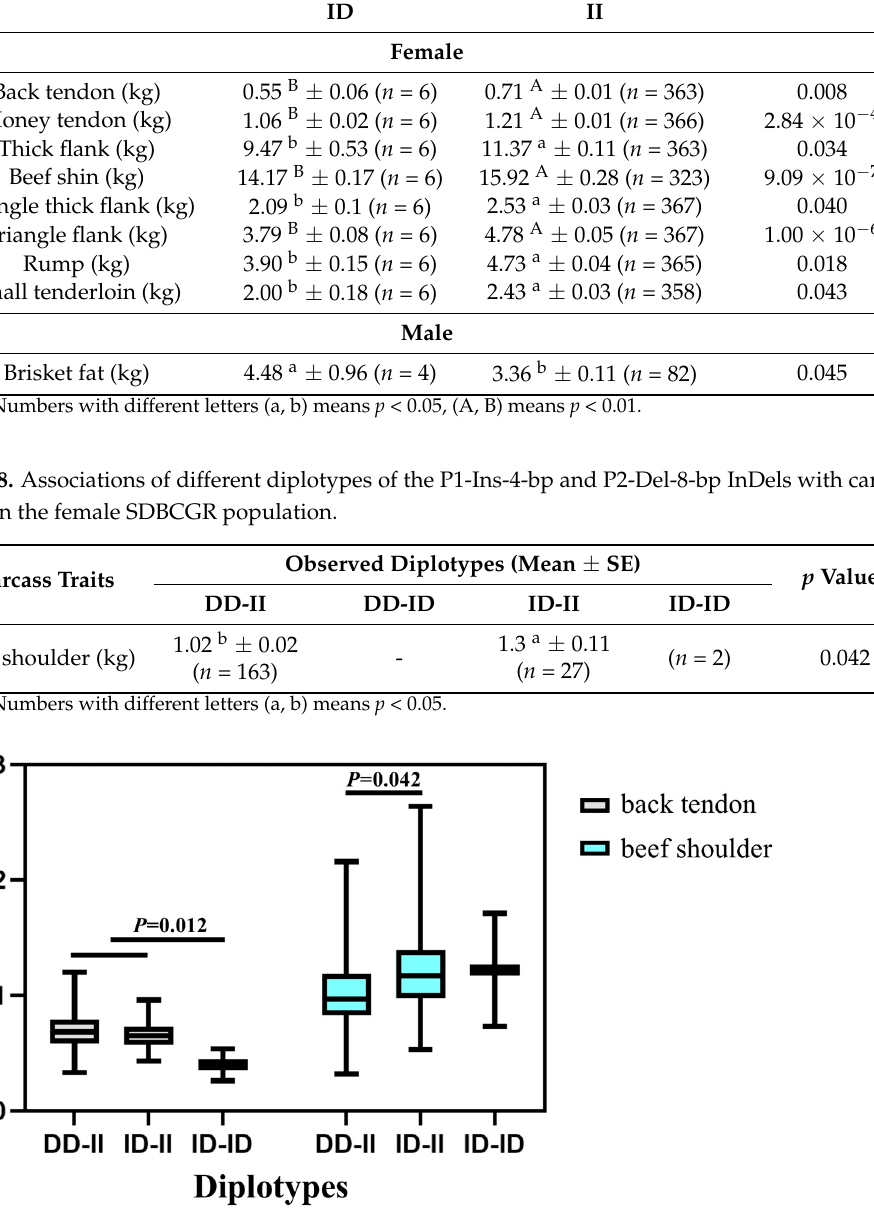
Figure 13. Association of diplotypes with carcass traits in the female SDBCGR